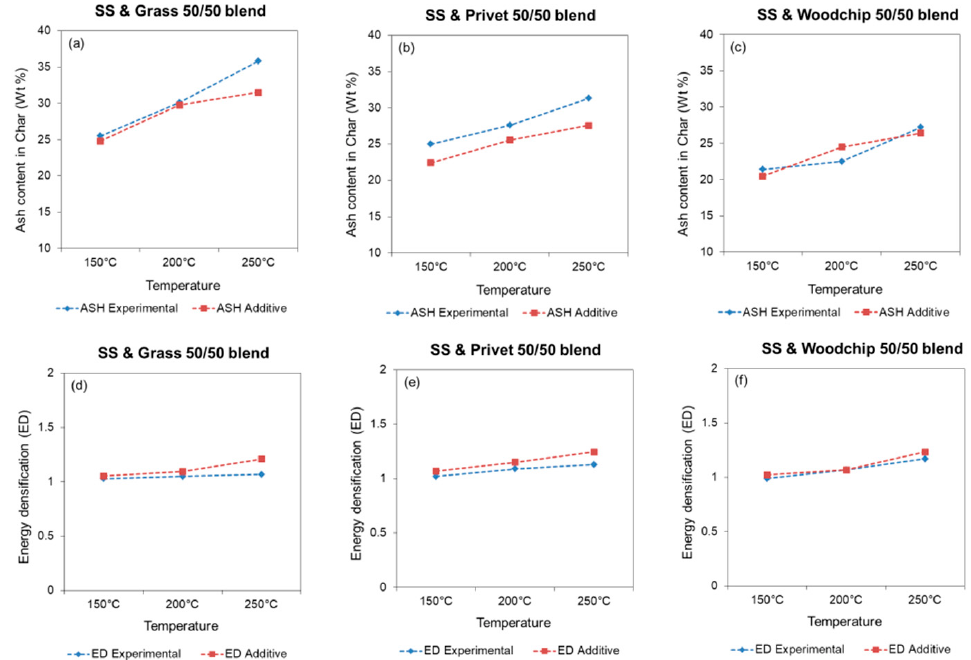
Figure 4. Comparison of experimental and additive levels in the hydrochar of ( a ) ash for SS and grass at 50/50 blend, ( b ) ash for SS and privet hedge at 50/50 blend, ( c ) ash for SS and woodchip at 50/50 blend, ( d ) ED for SS and grass 50/50 blend, ( e ) ED for SS and privet hedge for 50/50 blend, and ( f ) ED for SS and woodchip for 50/50 blend.